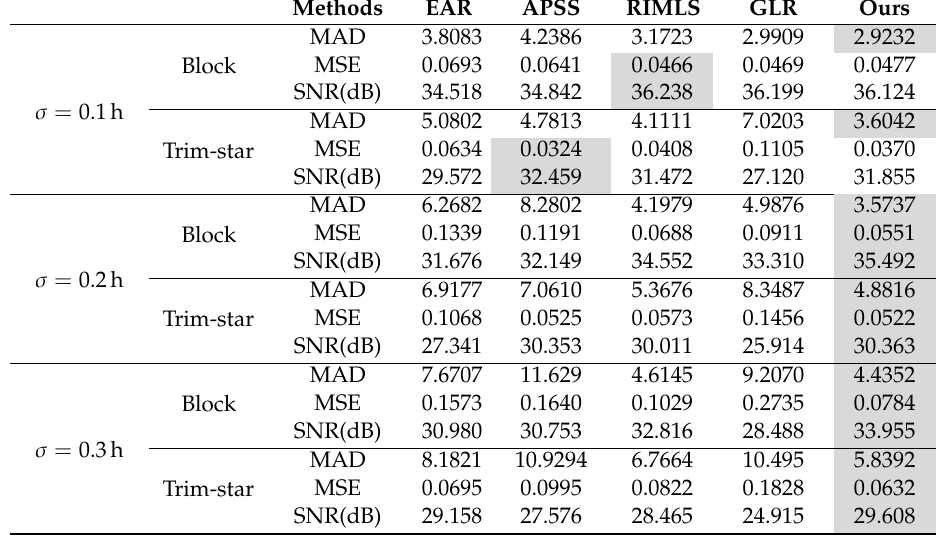
Table 3. The results of the error metrics of di ff erent compared methods for two Block and Trim-star objects varying the noise